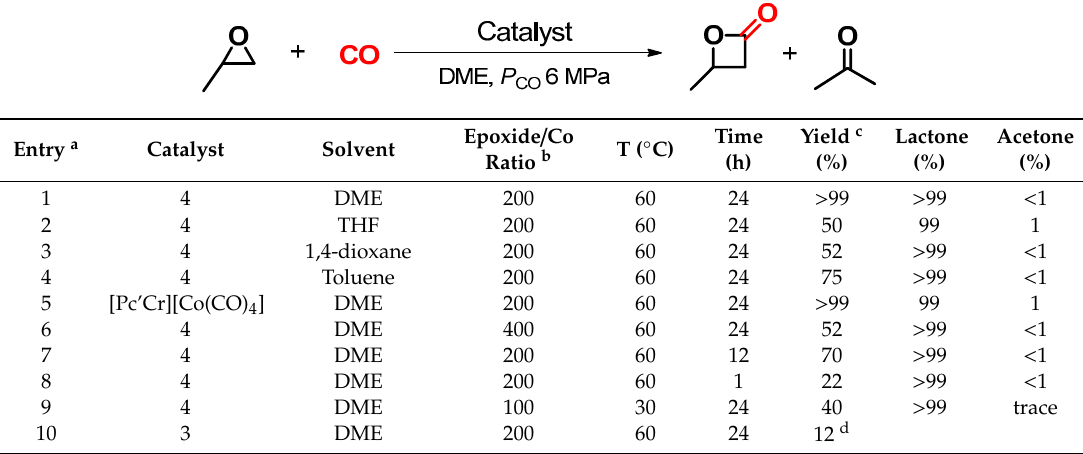
Table 1. Carbonylation activity of catalyst 4.